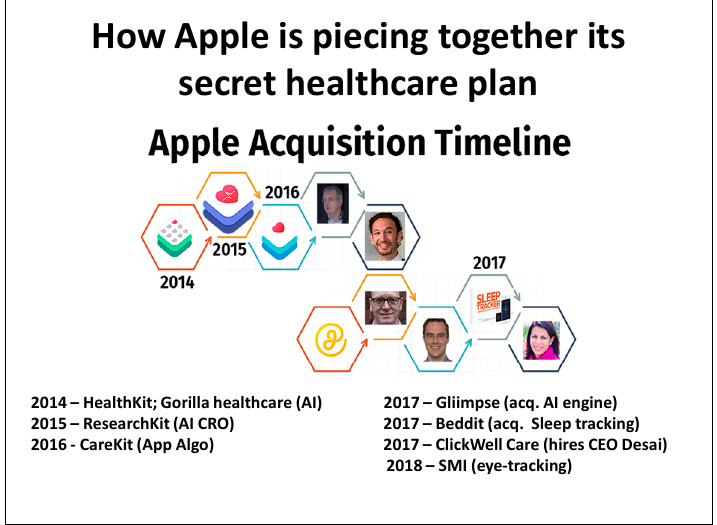
Figure 1. How Apple is piecing together its secret healthcare plan.